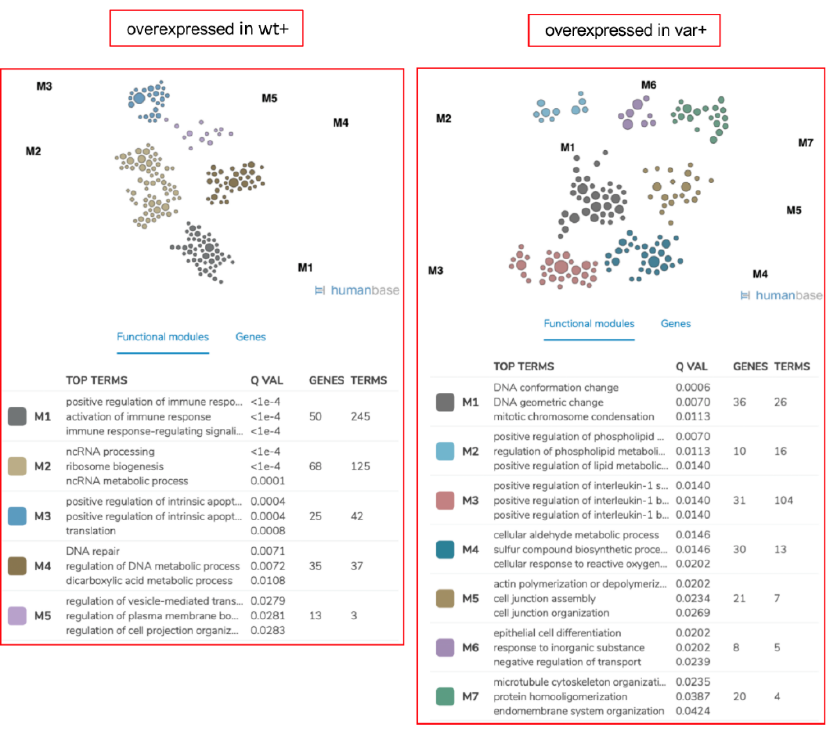
Figure 5. Pathway analysis in H187 (LY3828) and p.H187Q homozygous variant (LY4759) cells. The screenshot of the pathway analysis performed with HumanBase on the clusters of proteins obtained by Nano-LC mass spectrometry is shown. The 5 modules of pathways enriched based on the cluster of protein overexpressed in wt+ with respect to var+ are on the left, while the 7 enriched pathway modules in the cluster of protein overexpressed in var+ with respect to wt+ are on the right.